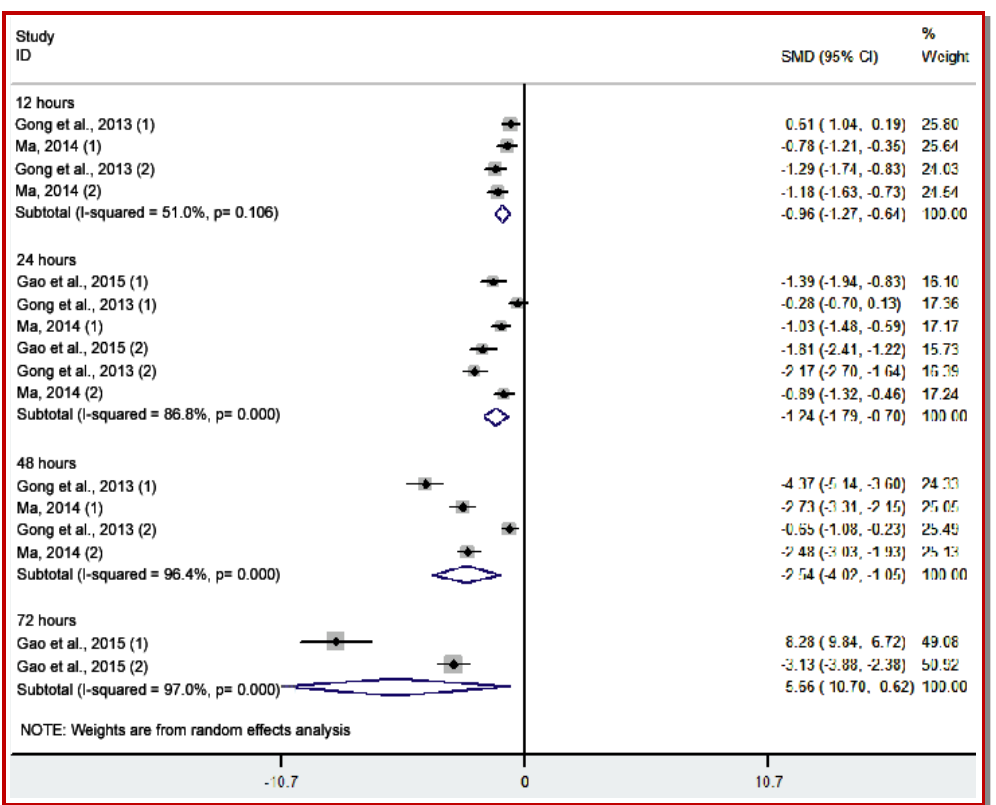
Figure 15: Meta-analysis of beta-blocker on the interleukin-1 β (digit within the parenthesis means the number of studies for com- parison) G. Chronic medical conditions and risk of sepsis. PLoS One. 2012; 7: e48307. Wei F, Dong H, Lu L, Xue H. Protective effect of esmolol on myocardium of systemic sepsis patients. World Latest Med Inf. 2013; 13: